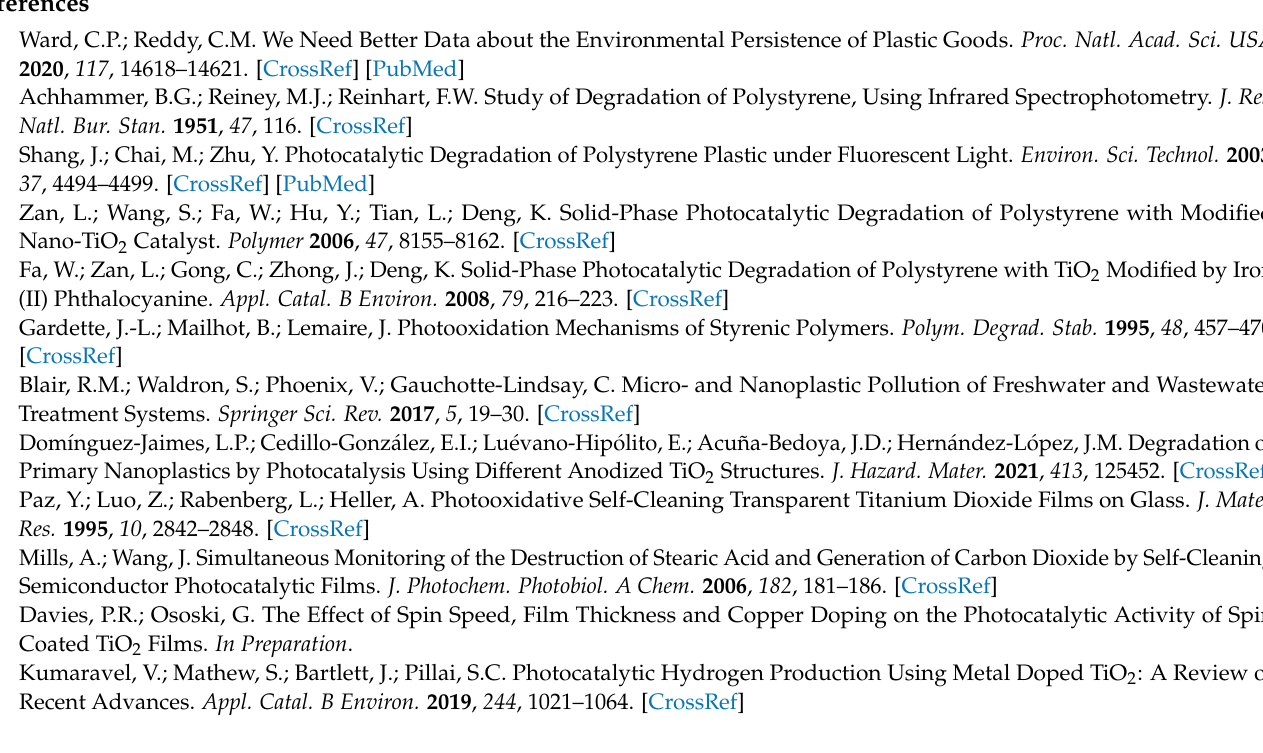
Figure S3: Tauc Plots and calculated band gaps of the spin coated 0.1 wt% TiO 2 catalysts; Figure S4: Photoelectron spectra of the Cu-doped TiO 2 catalysts deposited at different spin speeds and with different wt% of Cu; Figure S5: Further photoelectron spectra of the 0.1 wt% Cu-doped TiO 2 cat- alysts comparing the clean film with the polystyrene coated film before and after photocatalysis; Figure S6: PiFM micrographs of 0.1 wt% Cu-doped TiO 2 treated with polystyrene before and after photocatalytic